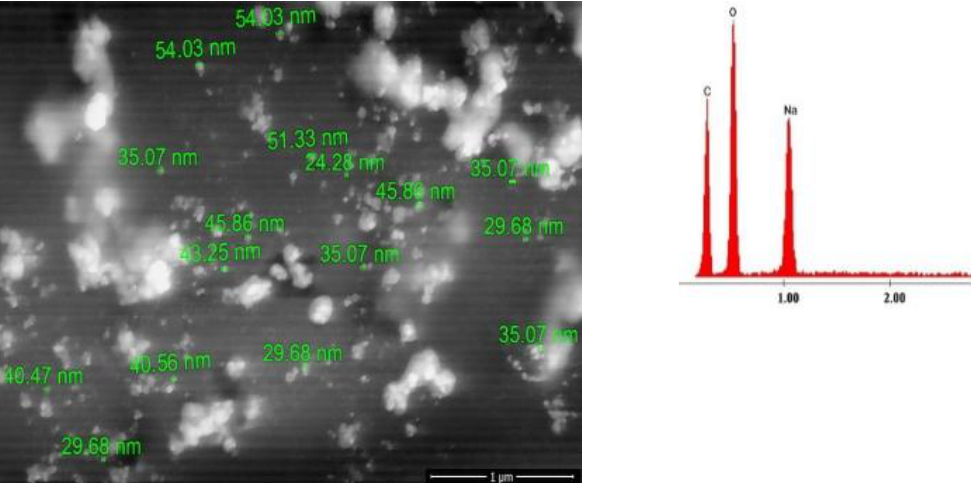
Figure 5. SEM and EDX analysis for the AgNPs. Figure 4. SEM and EDX analysis for the AgNPs.